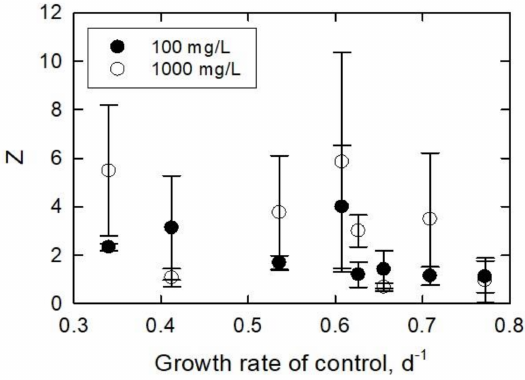
Figure 9. Normalized specific lipid peroxidation plotted against the measured growth rates of the control